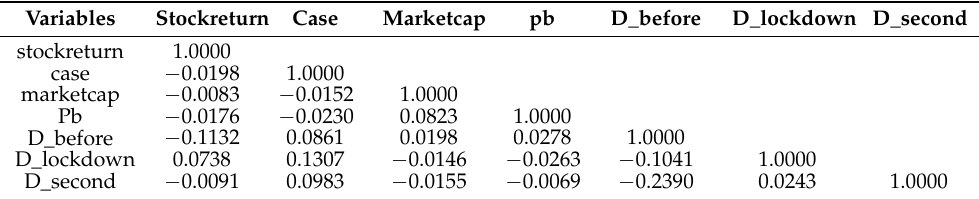
Table 3. Correlation matrix for models’ explanatory variables (Source: Authors’ calculation and